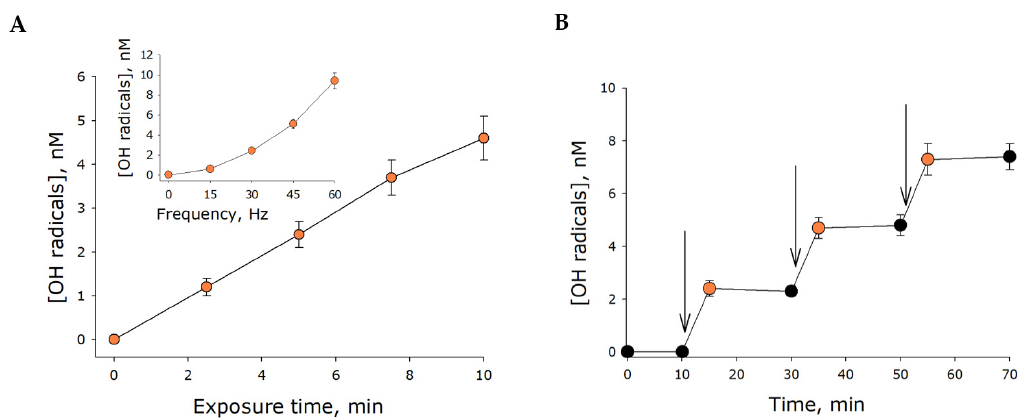
Figure 6. Hydroxyl radical generation in water under mechanical stress (30 Hz, amplitude of 5 mm). ( A ) The effect of exposure time on hydroxyl radical concentration. The insert displays the effect of frequency of mechanical stress on hydroxyl radical concentration (amplitude of 5 mm, exposure time of 5 min). ( B ) Changes in hydrogen peroxide concentration following multiple mechanical stresses. The time of a single exposure was 5 min, with the frequency and amplitude of 30 Hz and 5 mm, respectively. The intervals during which mechanical stress was applied are indicated with vertical errors. The data are presented as the mean and standard error of the mean for six independent assays.